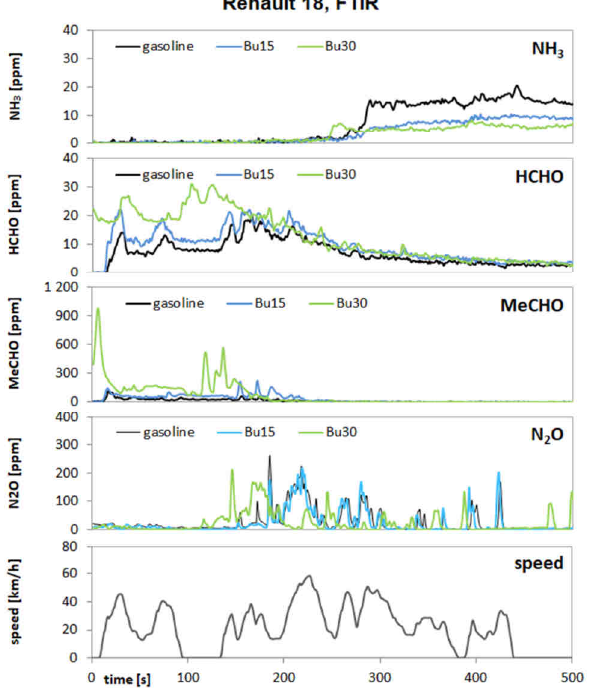
Fig. 10. Comparison of NH 3 -, HCHO-, MeCHO- & N 2 O-emissions in the first part of WLTC cold with different fuels